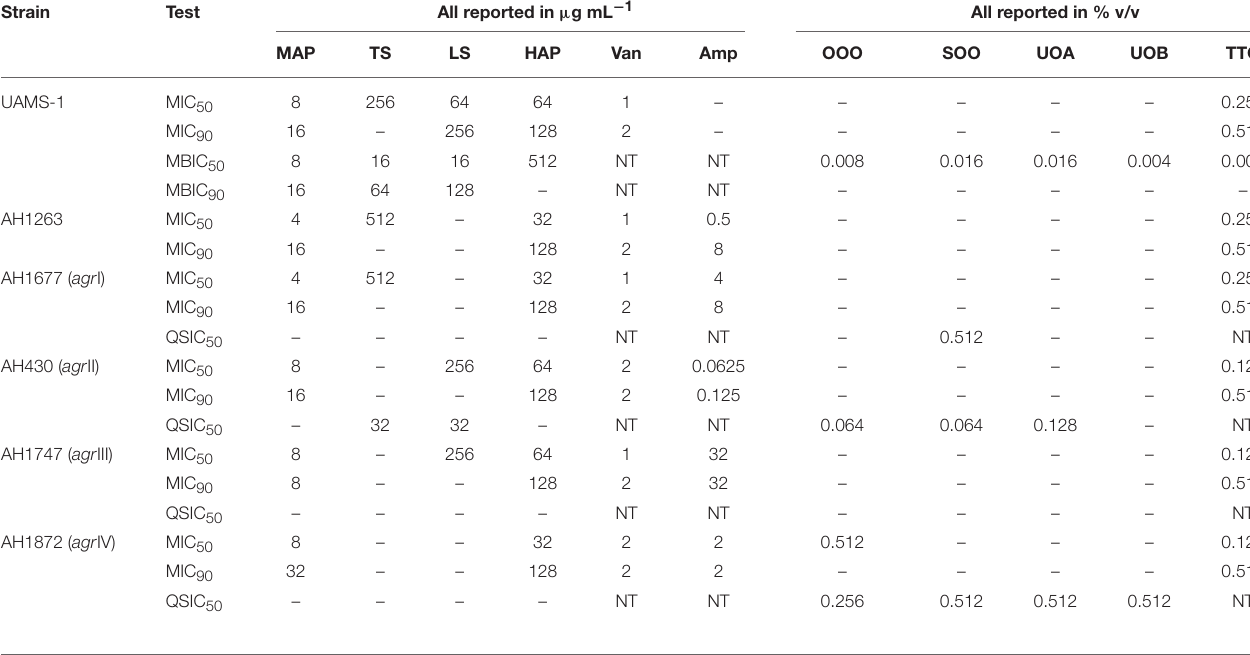
TABLE 3 | Summary of bioactivity